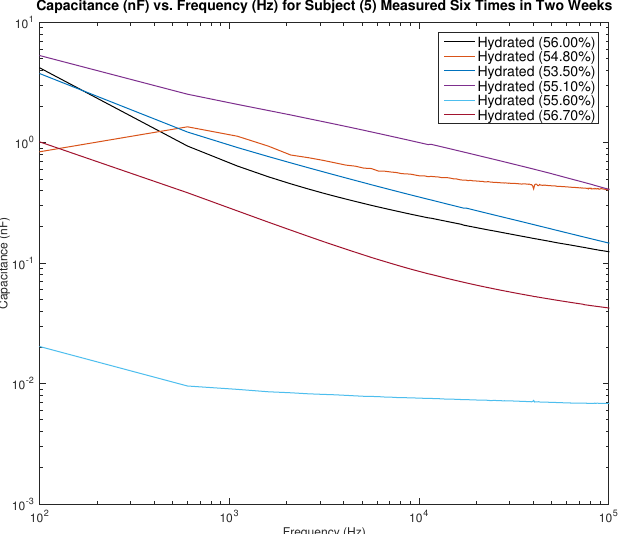
Figure 16. Testing results—capacitance (nF) vs. frequency (Hz) for subject 5 measured six times in two weeks on the right